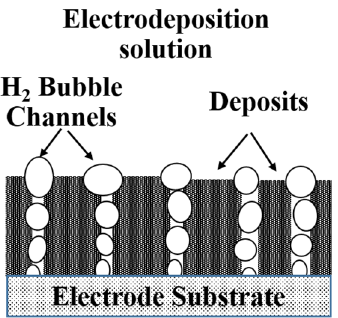
Figure 1. The schematic illustration of hydrogen bubble dynamic template.